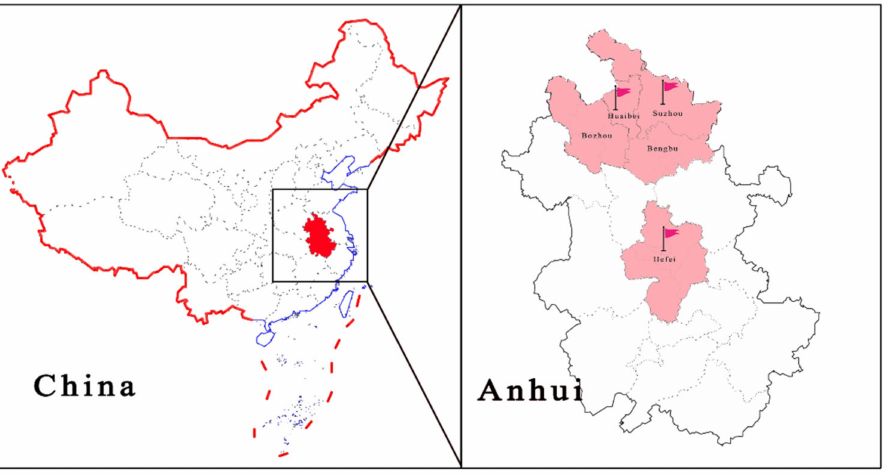
Figure 1. Geographic distribution of positive